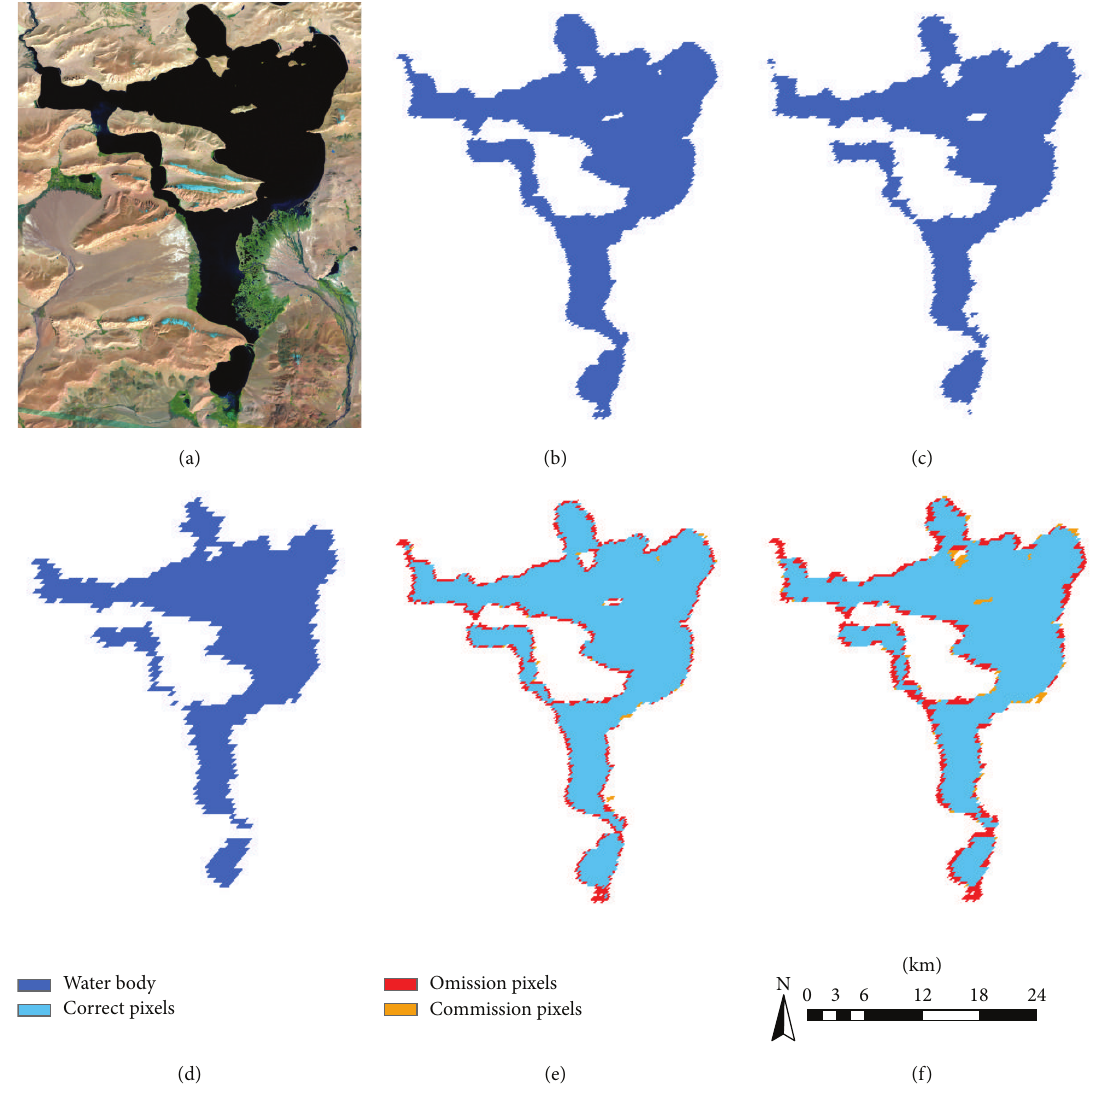
Figure 7: Visual performance in extracted water bodies and spatial errors for Co Ngoin; October 7, 2000. (a) Landsat-7 ETM+ 543 band false-color image; (b) aggregated reference water map from ETM+ image; (c) extracted result from downscaled image at 250 m; (d) extracted result from original image at 500 m; (e) result of spatial error for (c) map; (f) result of spatial error for (d)